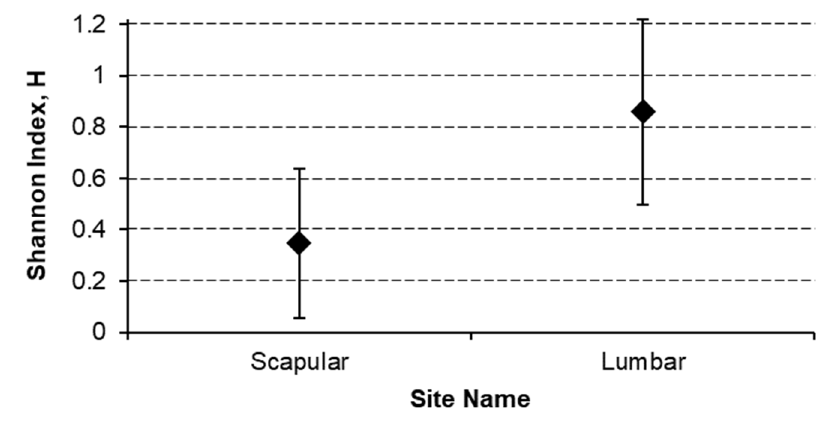
Figure 5. Lymphatic site heterogeneity comparison. Dorsal subscapularis region presented the most significantly ( p < 0.05) heterogeneous lymphatic laterality drainage (homolateral vs. bilateral) with a Shannon index of 0.606